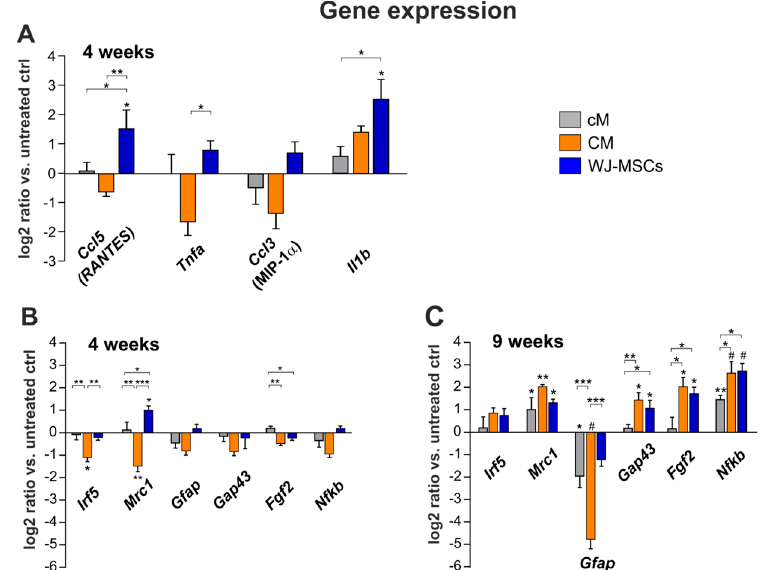
Figure 8. Relative expression of selected genes in the lesion 4 (A,B) and 9 weeks (C) after SCI. The graphs show the log2-fold changes of the ΔΔ C t values of the indicated genes in comparison to the animals treated with the saline. n = 4 per group, asterisks show statistical significance * p < 0.05, ** p < 0.01 and # p < 0.001 of a particular treatment, when compared to the saline treated control group. The significance between treated groups is * p < 0.05, ** p < 0.01 and *** p < 0.001.